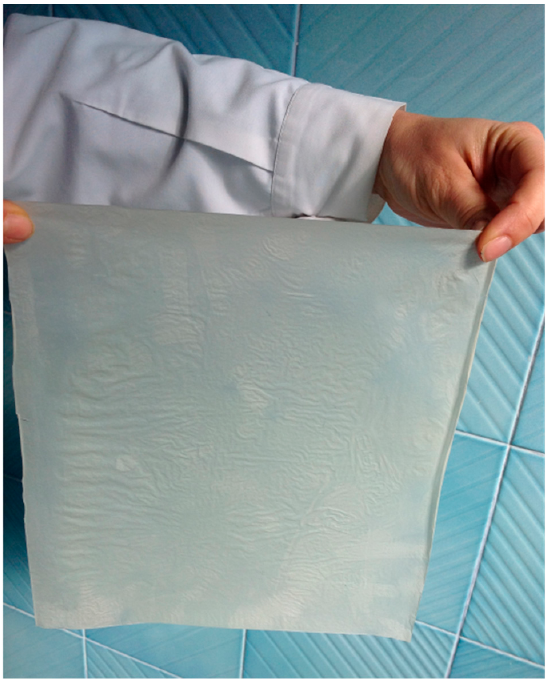
Figure 1. Example of chitin nanofibrils tissue obtained by electrospinning technology.